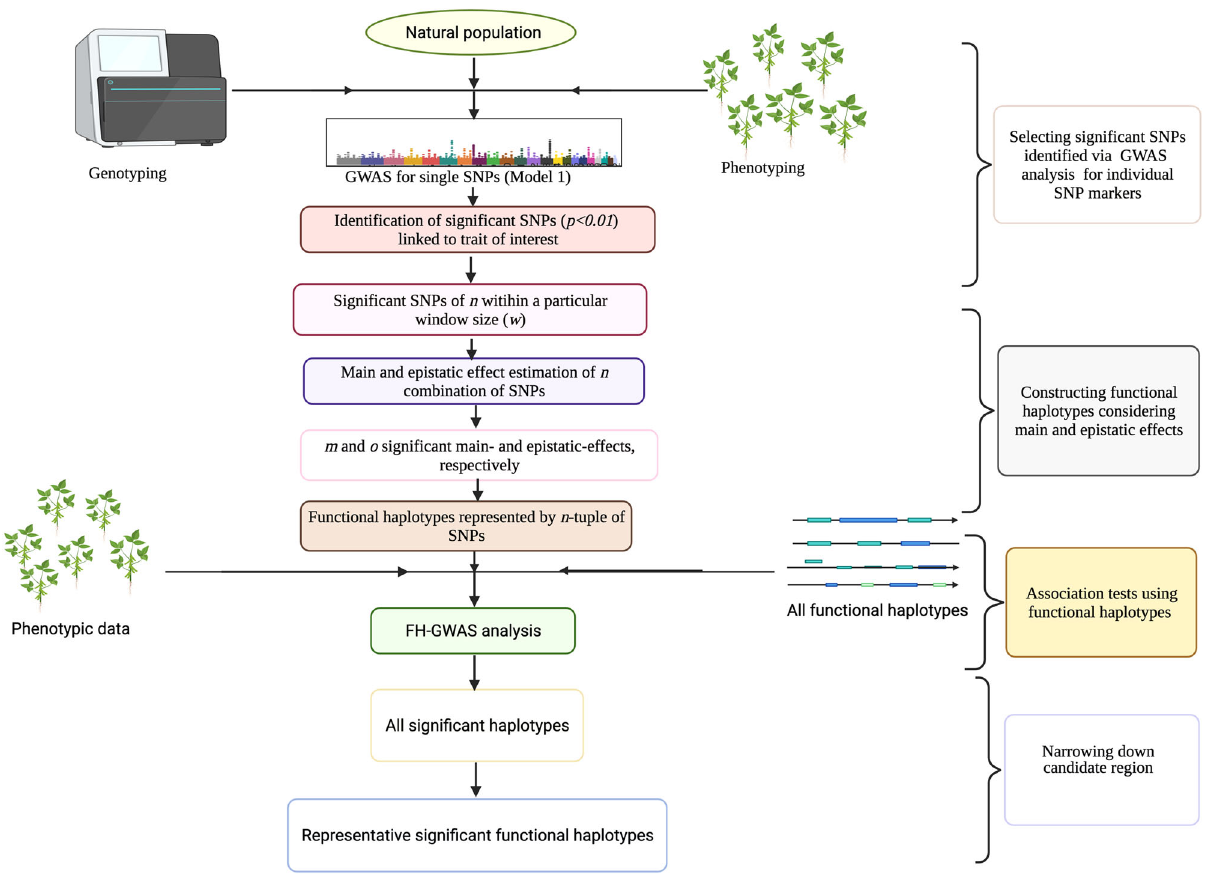
Fig. 3 Functional haplotype-GWAS (FH-GWAS) analysis for identi fi cation of the superior haplotypes for traits of interest. FH-GWAS approach fi